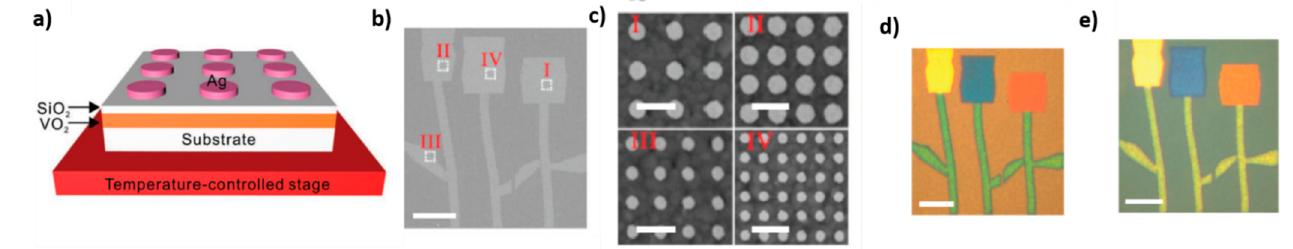
Figure 8. ( a ) Scheme of the structure proposed by Shu et al.; ( b ) SEM image of the pattern prepared for the visualization of tulips image by combining five different structures. Bar = 40 μ m; ( c ) SEM images of the four arrays contained in structures I-IV reported in ( b ). Scale bars correspond to 400 nm; ( d ) reflection image of tulips pattern, recorded at 20 °C. Scale bar corresponds to 40 μ m; ( e ) reflection image of tulips pattern, recorded at 80 °C. The scale bar corresponds to 40 μ m. Reproduced from Ref. [45] with permission from Wiley.